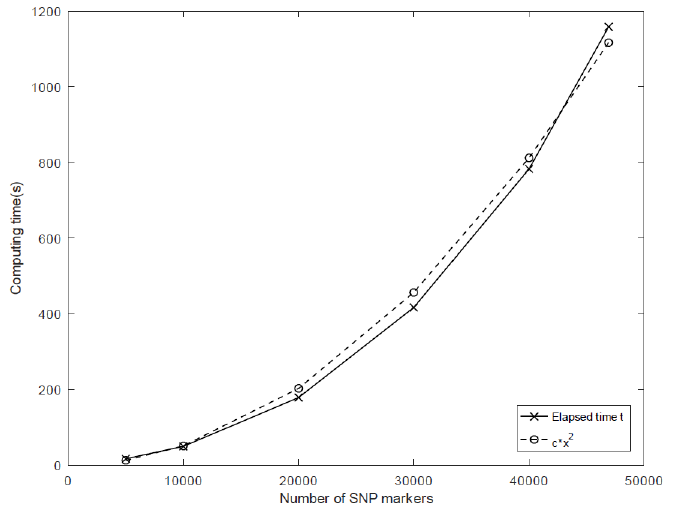
Fig. 2 . Computing time (in seconds) for 19757 individuals and an increasing number of SNPs 5000 to